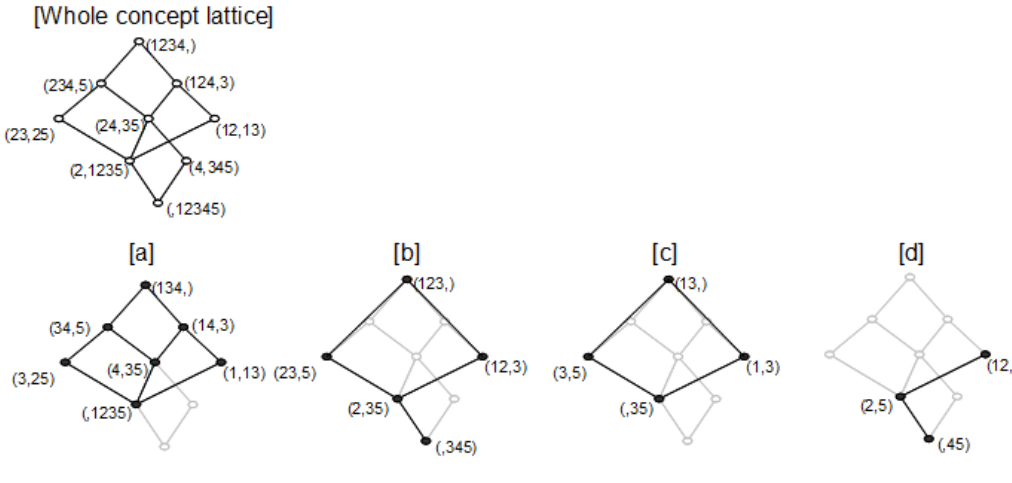
Figure 5. Concept lattices for full and